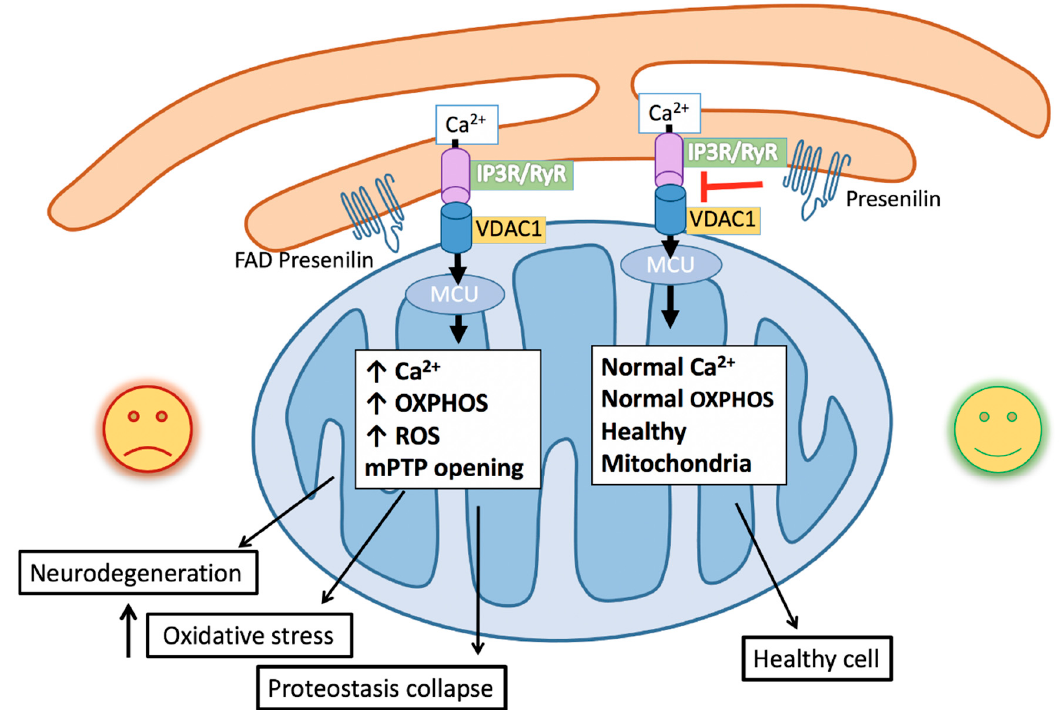
Figure 1. Schematic of familial Alzheimer’s Disease (FAD) mutations facilitating endoplasmic reticulum (ER)–mitochondrial calcium transfer. Increased calcium release from the IP 3 receptor (IP3R) and Ryanodine receptors (RyR) at the ER mitochondrial-associated membranes (MAMs) is taken up through the voltage-dependent ion channel (VDAC) on the mitochondrial outer membrane and the calcium-selective mitochondrial calcium uniporter (MCU) on the mitochondrial inner membrane. Increased mitochondrial calcium stimulates oxidative phosphorylation, leading to increased reactive oxygen species (ROS) generation, which promotes oxidative stress, mitochondrial permeable transition pore (mPTP) opening and apoptosis, protein misfolding and proteostatic collapse, and neurodegeneration.